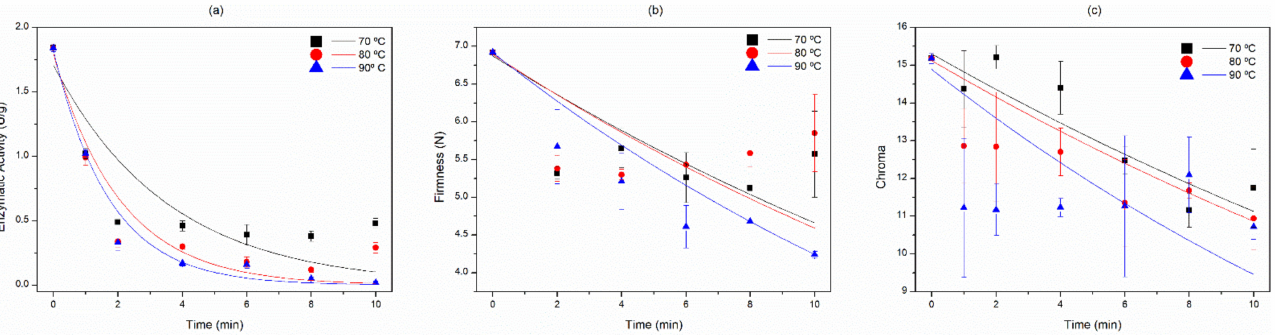
Figure 3. Effect of blanching fresh cowpeas in different temperature–time binomials under denatu- ration on: ( a ) enzymatic activity (U/g), ( b ) firmness (N), and ( c ) color saturation according to the chroma